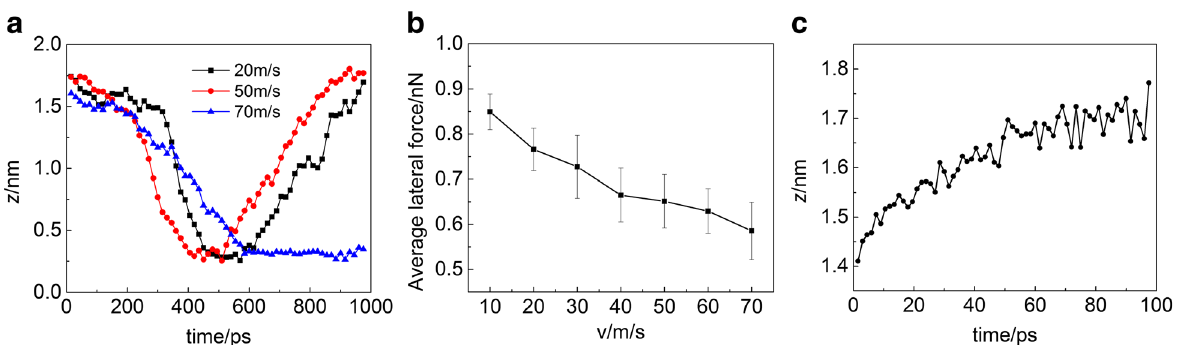
Fig. 4 a The coordinate of a C atom on carbon nanotube in the z direction as a function of time when the carbon nanotube moves at speeds of 20, 50, and 70 m/s. b The mean friction forces ’ curve with the velocities of carbon nanotube. c The coordinate of a C atom on the carbon nanotube in the z direction when the hydroxyl groups ’ ratio on carbon nanotube and Si substrate is 5%/10%. The applied constant external force on the carbon nanotube is 0.000625 nN in the x direction